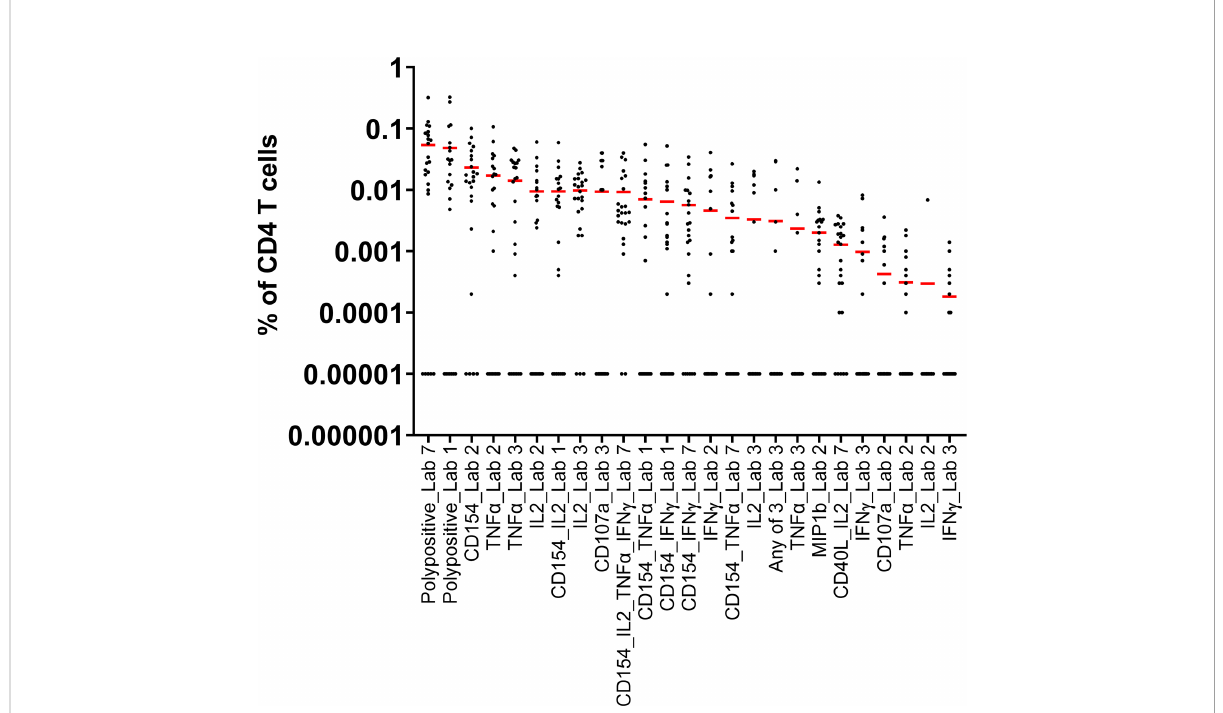
FIGURE 1 Pilot Study 1: Evaluation of data from each of the participating laboratories. Each dot represents the A/California/07/2009 stimulated and background subtracted % of parent cells for a single sample. The red line indicates the mean of the 24 samples for each outcome for each laboratory. All 0 values were replaced by 0.00001 in order to represent the data. Seven laboratories participated in pilot study 1, however one laboratory did not provide data in time for inclusion in the assessment of the results. IFN, interferon; IL, interleukin; TNF, tumor necrosis factor.